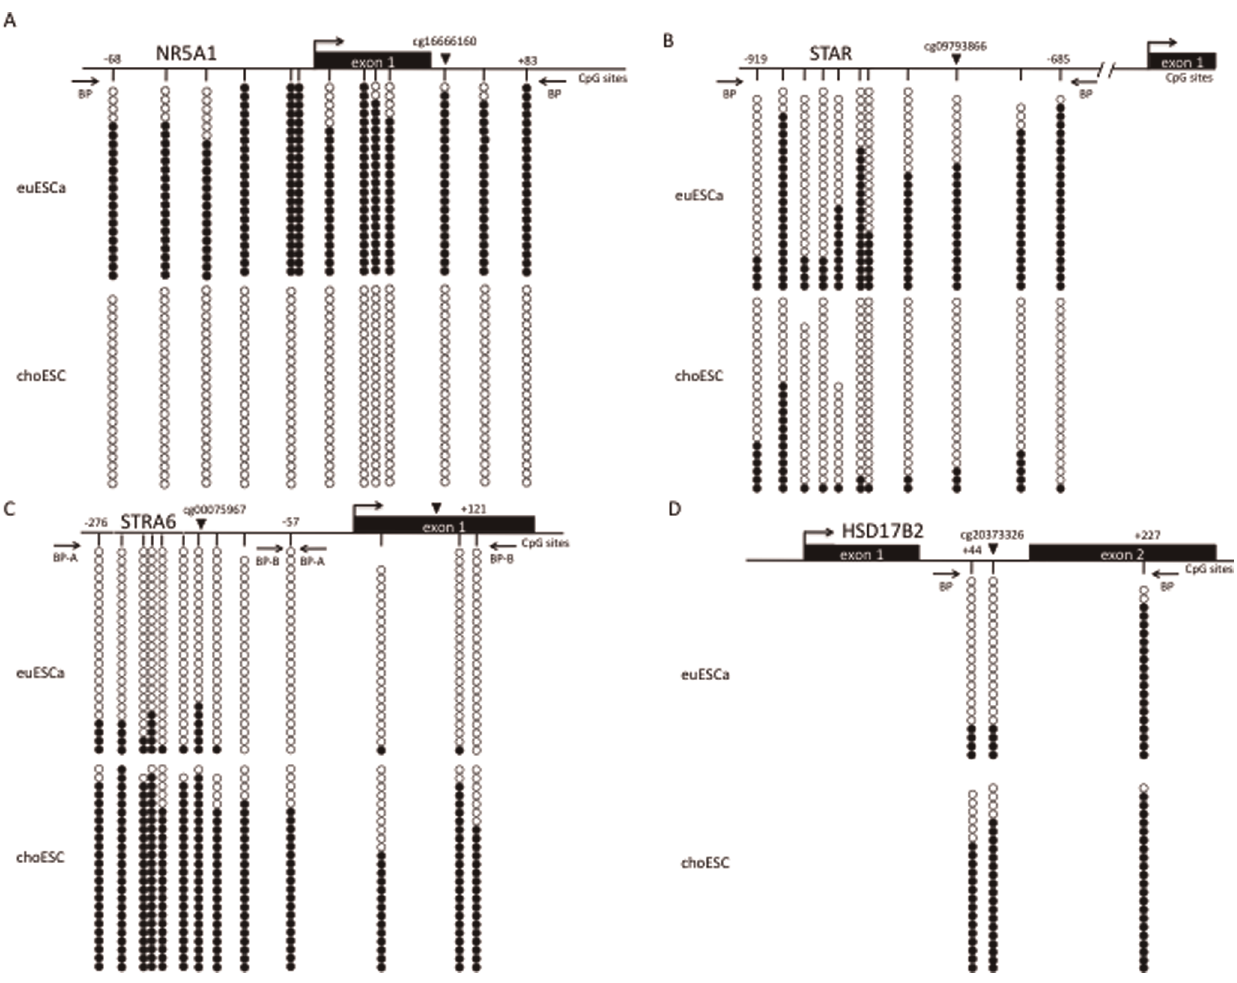
Figure 4. The results of the sodium bisulfite sequencing analyses of NR5A1 (A), STAR (B), STRA6 (C) and HSD17B2 (D) in the euESCa and choESC samples. The DNA methylation profile in the genomic regions of the NR5A1, STAR, STRA6 and HSD17B2 genes was analyzed by a sodium bisulfite sequencing method in a pair of euESCa and choESC from one individual, which had already been analyzed by the Infinium method. In NR5A1 and STRA6, the DNA methylation status of the proximal promoter and first exon was analyzed. The primer pairs BP-A and BP-B amplify region A and B, respectively, in STRA6. In STAR, the distal promoter region was analyzed. In HSD17B2, the first intron and second exon region were N analyzed. The arrows indicate the positions of the bisulfite primers. Closed triangles represent the CpG sites analyzed by the Infinium method, and are , methylated CpG sites; q , unmethylated CpG sites; BP, bisulfite primer. accompanied by the identification names.